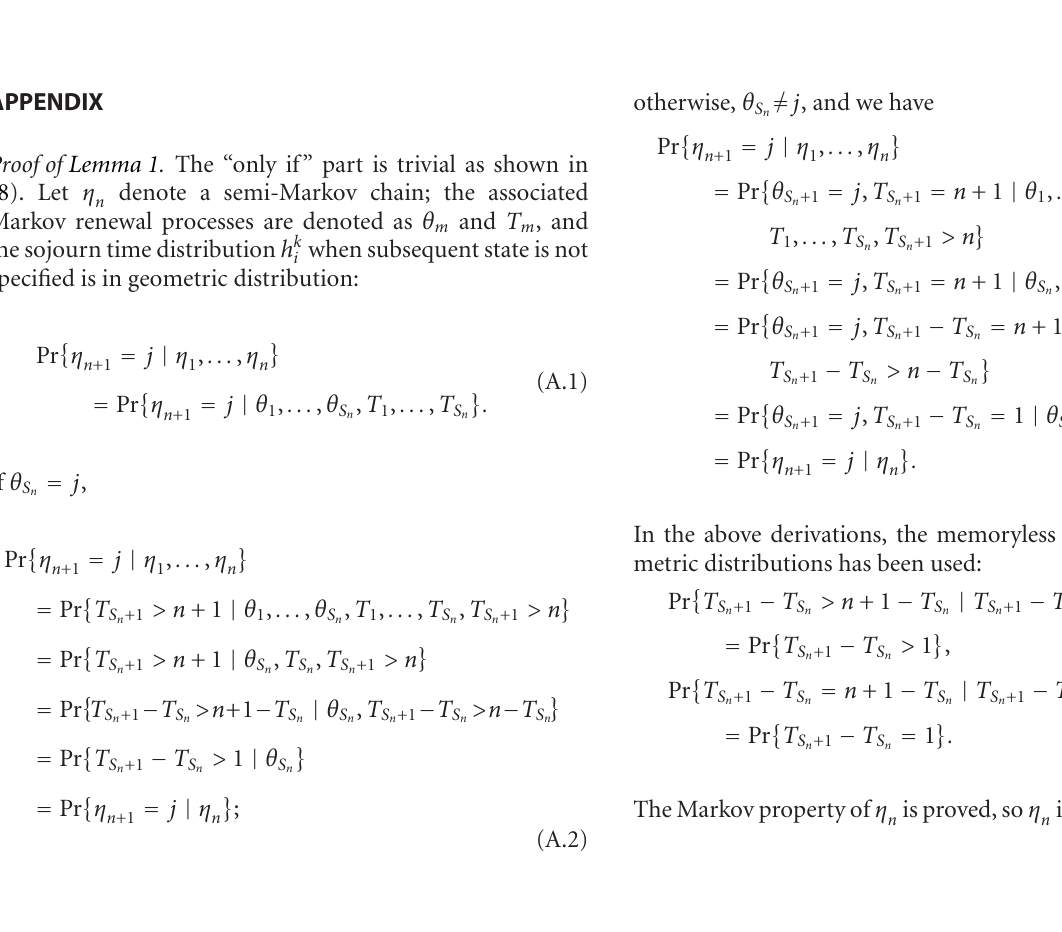
Figure 10: Comparison of transition